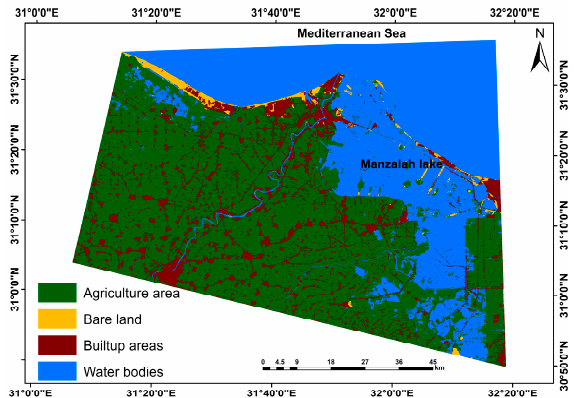
Figure 2. LULC map of the study area.